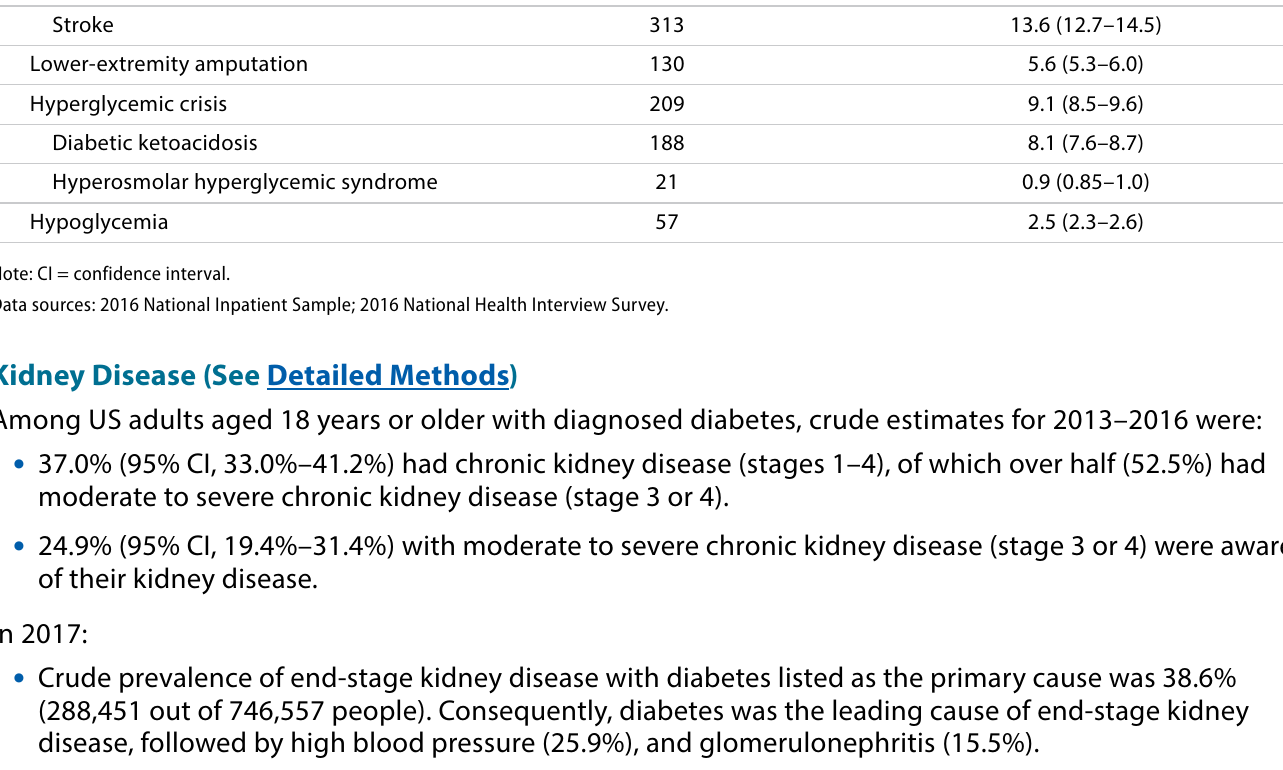
Table 6. Number and rate of hospitalizations per 1,000 adults aged 18 years or older with diabetes for selected causes, United States, 2016 Risk Factor Number in thousands Crude rate per 1,000 (95% CI) Diabetes as any listed diagnosis Major cardiovascular